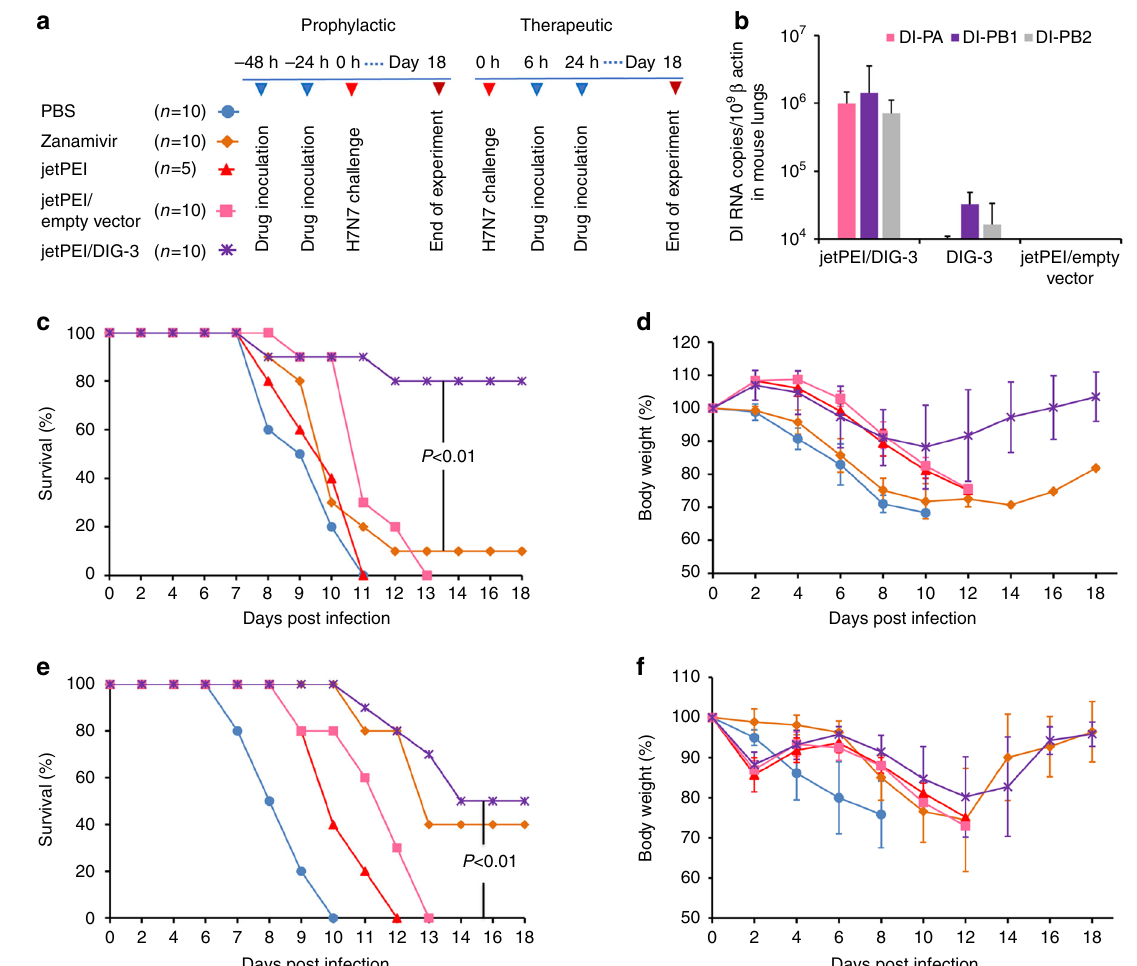
Fig. 3 The jetPEI/DIG-3 could provide potent anti-A(H7N7) virus ef fi cacy in mice. a Experimental design for evaluating antiviral ef fi cacy of jetPEI/DIG-3 in mice. b Expression of DI-PA, DI-PB1, and DI-PB2 RNAs in mouse lungs when jetPEI/DIG-3 (5 μ g per mouse), DIG-3, jetPEI/empty vector were intratracheally inoculated to mouse lungs. Three mice in each group were included. c , d Prophylactic ef fi cacy of jetPEI/DIG-3 against A(H7N7) virus. e , f Therapeutic ef fi cacy of jetPEI/DIG-3 against A(H7N7) virus. For prophylactic experiment, 40 μ l of PBS ( n = 10), zanamivir (50 μ g in PBS, n = 10), jetPEI (0.7 μ l in 5% glucose solution, n = 5), jetPEI/empty vector (0.7 μ l/5.0 μ g in 5% glucose solution, n = 10), and jetPEI/DIG-3 (0.7 μ l/5.0 μ g in 5% glucose solution, n = 10) were intratracheally inoculated to corresponding mice at 48 and 24 h before viral inoculation. For therapeutic experiment, PBS, zanamivir, jetPEI, jetPEI/empty vector and jetPEI/DIG-3 were intratracheally inoculated to corresponding mice at 6 and 24 h after viral inoculation. Survivals and body weight data were generated from 5 to 10 mice in each group with mean ± SD. P values were calculated by Gehan – Breslow – Wilcoxon